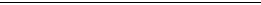
Table 6 maps simplified equivalents to STTS and